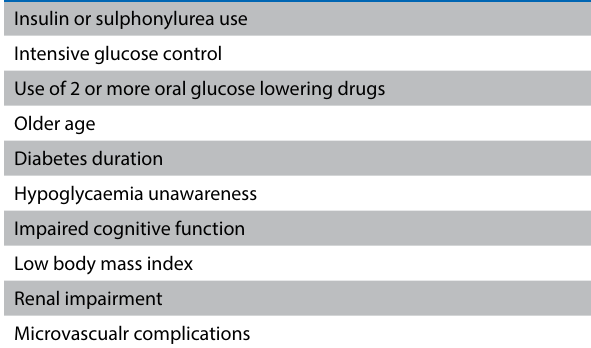
Figure II: Independent risk factors for severe hypoglycaemia 17,20 Insulin or sulphonylurea use